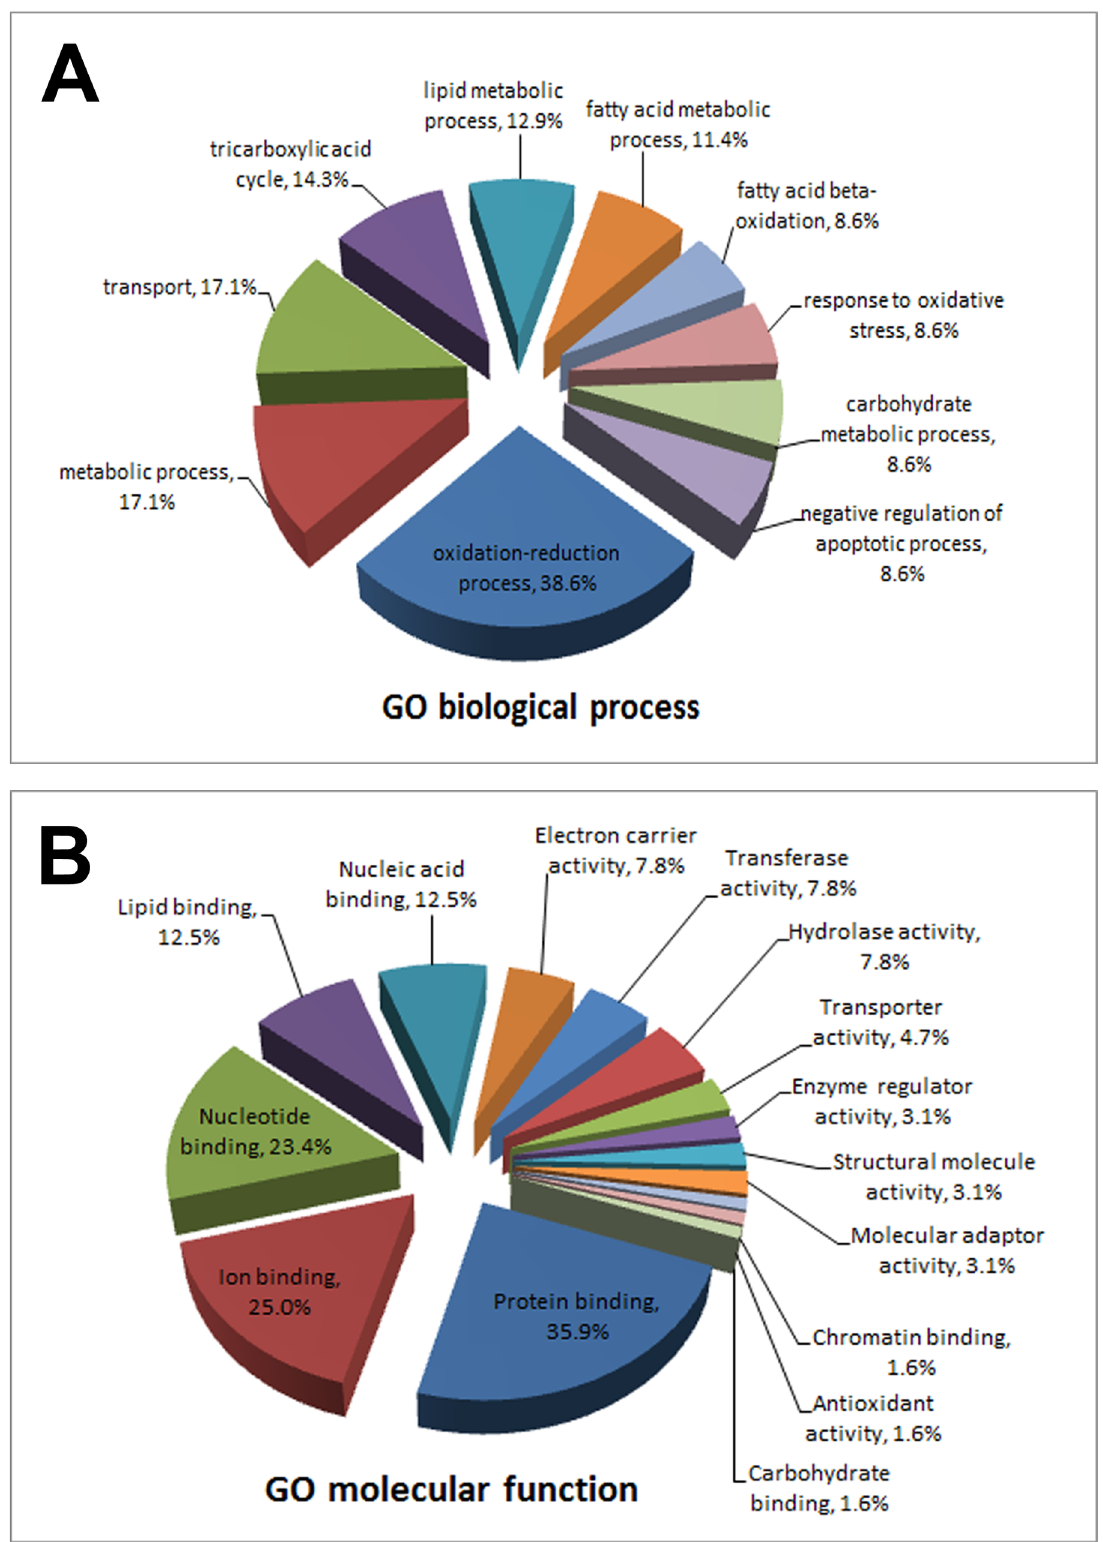
Fig 2. Gene ontology (GO) analysis of S -sulfhydrated aortic proteins. The proteins were analysed in terms of (A) GO biological process and (B) GO molecular function of proteins.